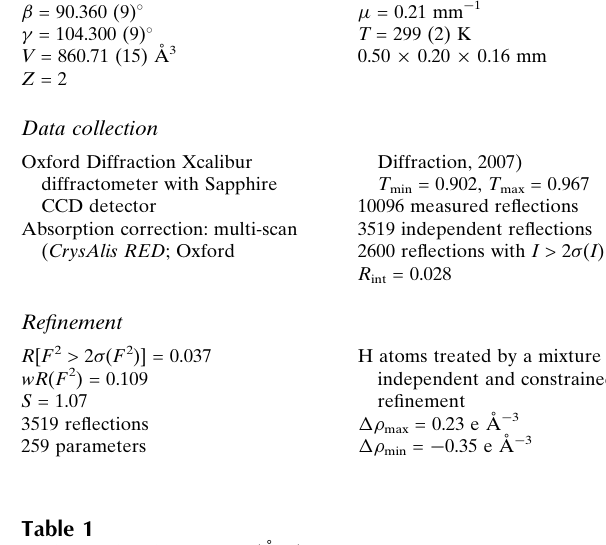
Hydrogen-bond geometry (A˚ , (cid:1)